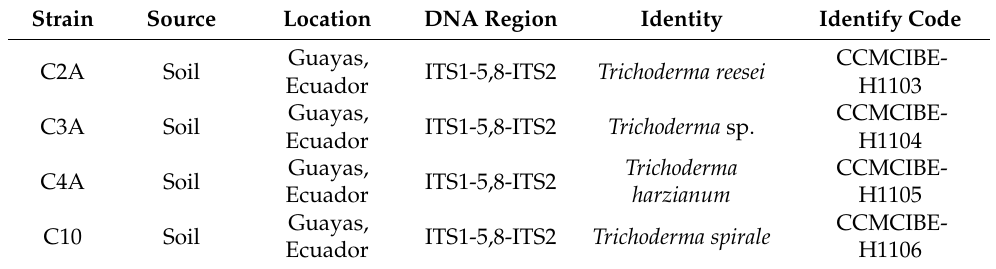
Table 3. Summary of Trichoderma species identified by ITS region from the rhizosphere of cocoa plants. Strain Source Location DNA Region